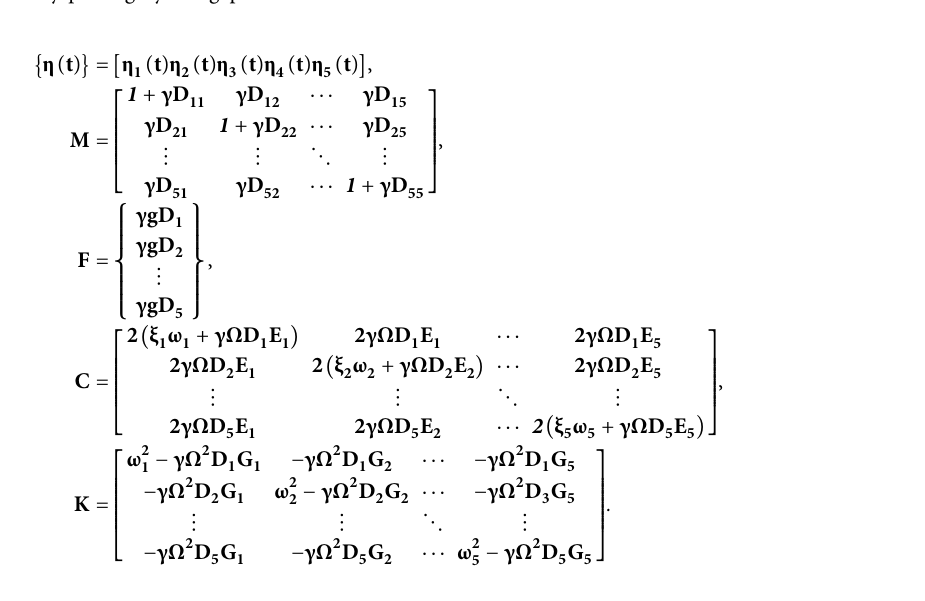
Figure 6: Spectrum of measured vertical acceleration at hinge point: (a) trolley passing through landside girder, (b) trolley passing through waterside girder, and (c) trolley passing by rail